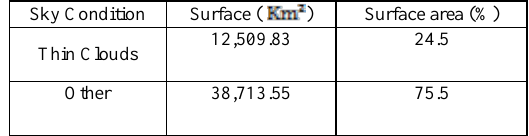
Figure 23: Thin clouds concluded from threshold placing of the second group of models ( April 20 th ) Table 9: Surface of thin clouds in the area concluded from threshold placing of the second group (April 20 th